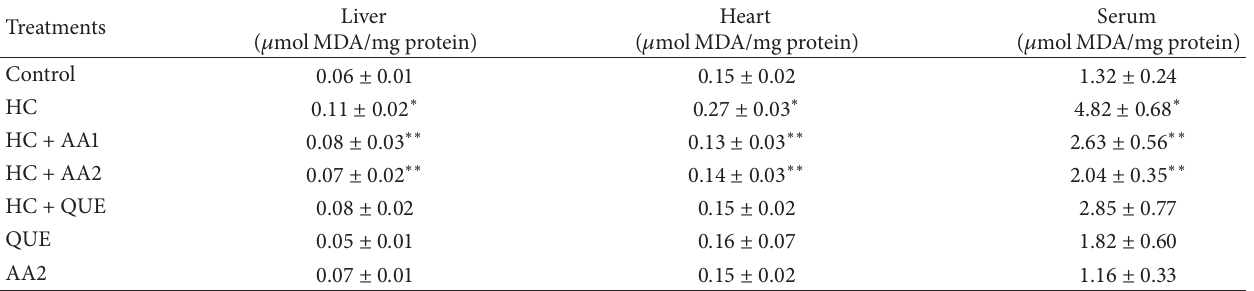
Table 3: Changes in the levels of lipid peroxidation in hypercholesterolemic rats treated with methanol extract of Artocarpus altilis for nine weeks.